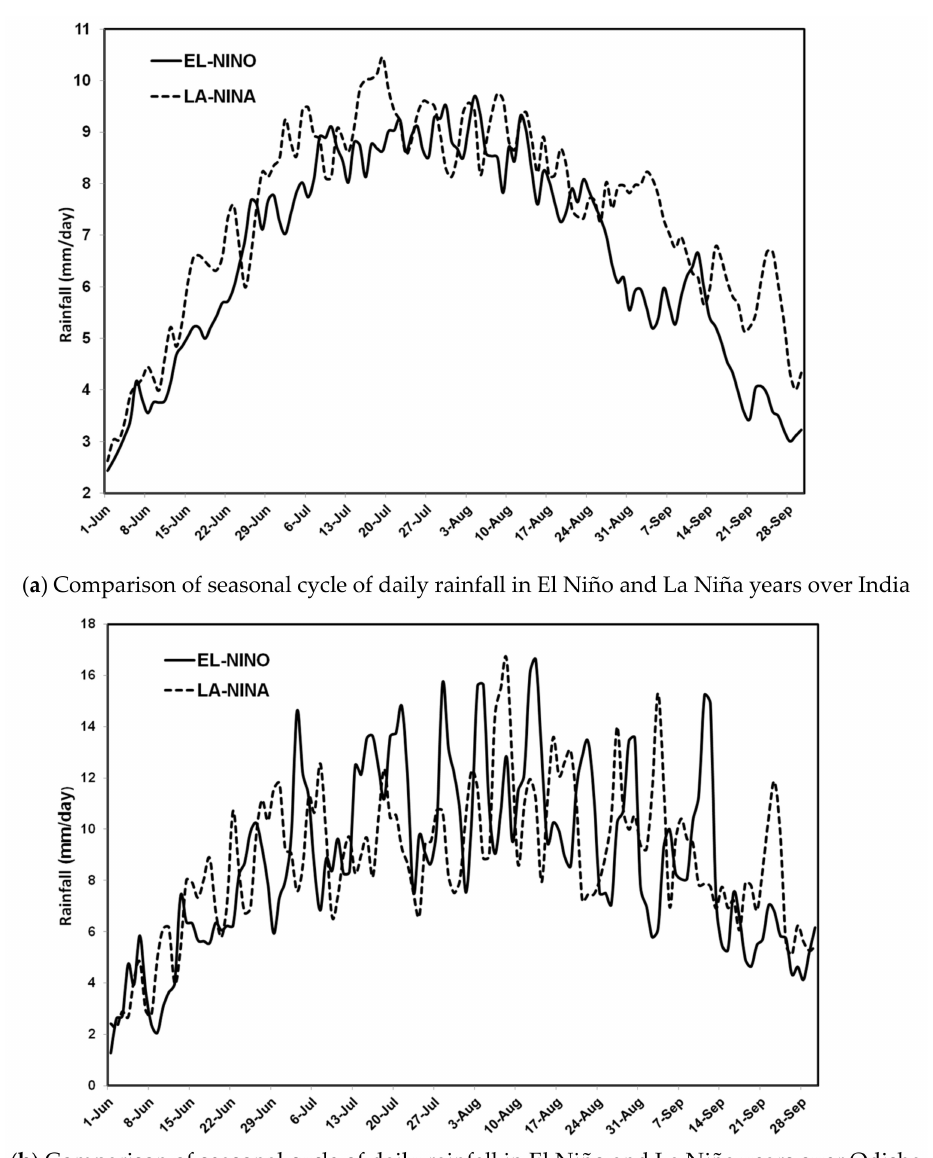
Figure 8. Seasonal cycle of the daily rainfall climatology during the monsoon period (1 June to 30 September) averaged over ( a ) India and ( b ) Odisha composite over the El Niño (thick line) and La Niña (dotted line) years for the period 1 June to 32 September. The analysis is averaged over the El Niño and La Niña years